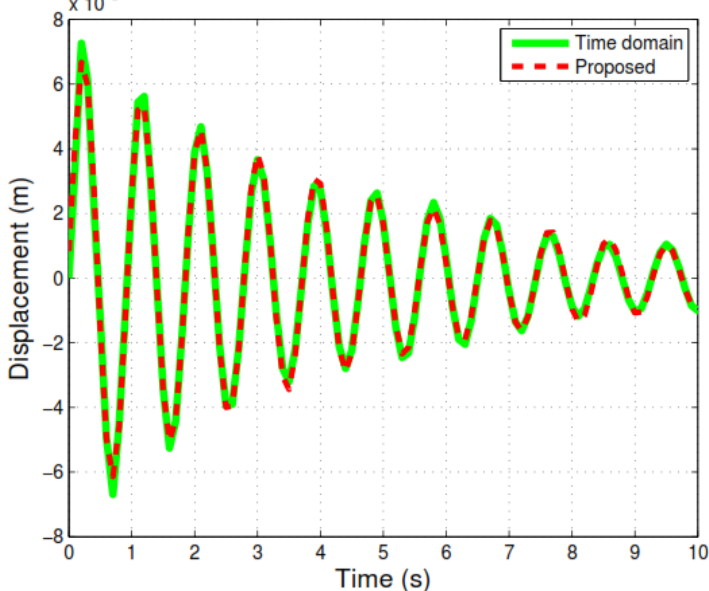
Figure 5. The response comparison at the top of the tower in the y direction when only a nonzero velocity is applied.